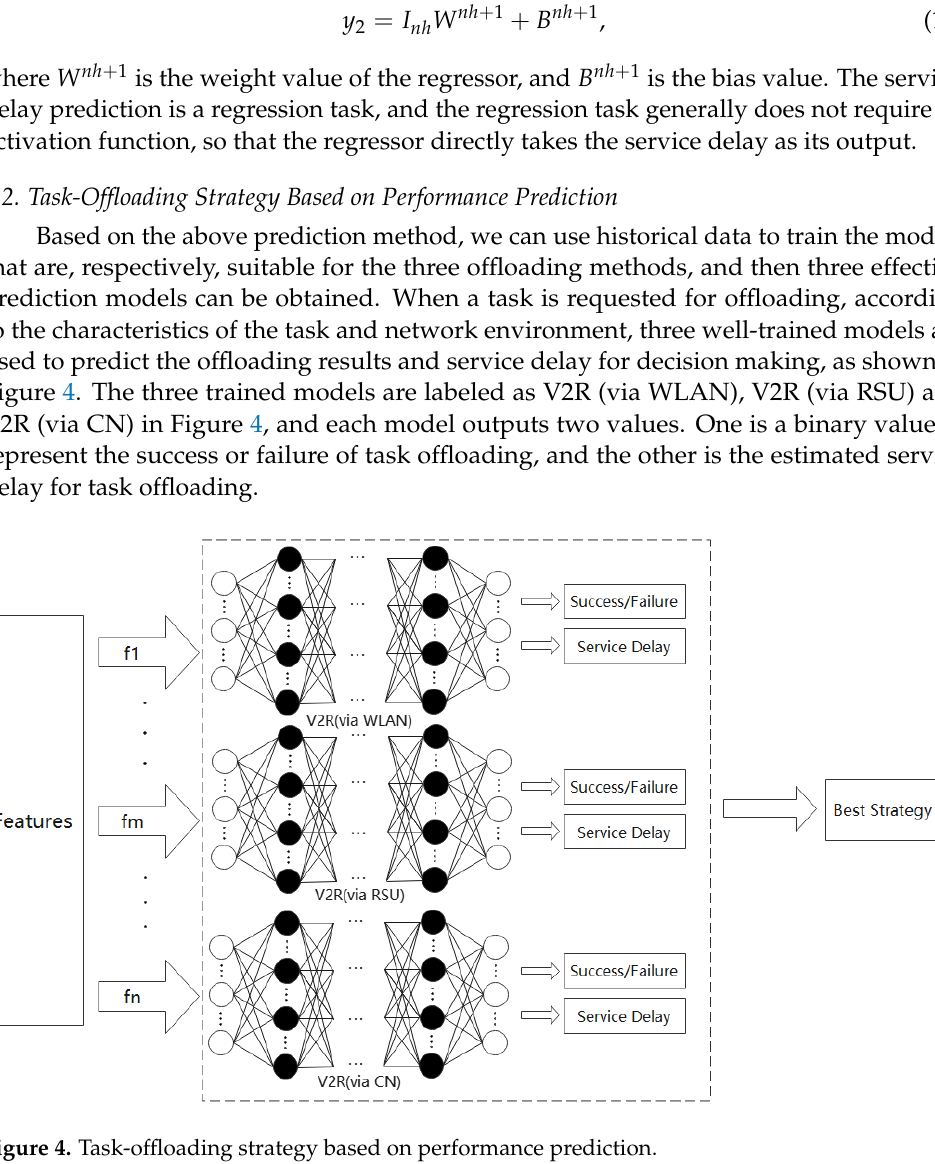
Figure 4. Task-offloading strategy based on performance